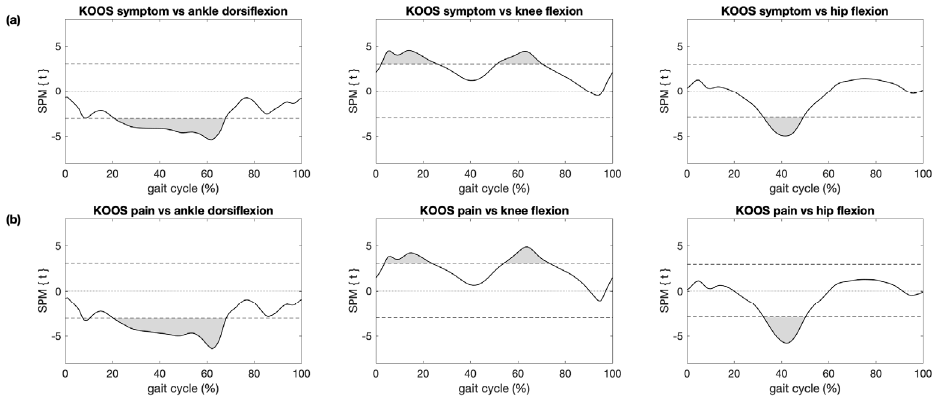
5 Figure 5. Association between KOOS subscores and kinematic trajectories. Results of statistical para- metric mapping with regression analysis (SPM{t}) are shown for ( a ) the KOOS subscore symptoms and ( b ) the KOOS subscore pain and the ankle (left), knee (center) and hip (right) of the affected/left leg where grey areas illustrate regions with statistically significant relationships between KOOS subscores and kinematics ( p < 0.05).